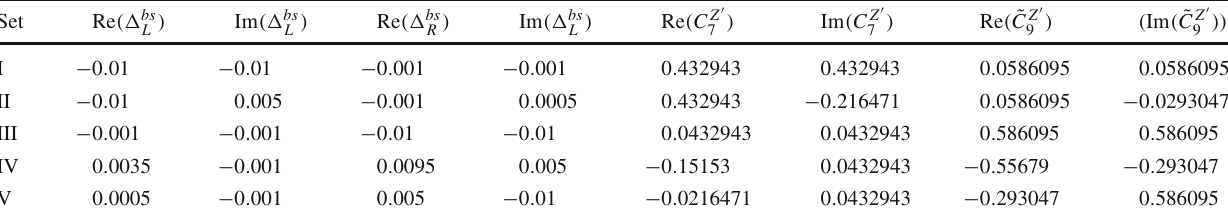
Table 4 Predictions of C Z (cid:3) constraints